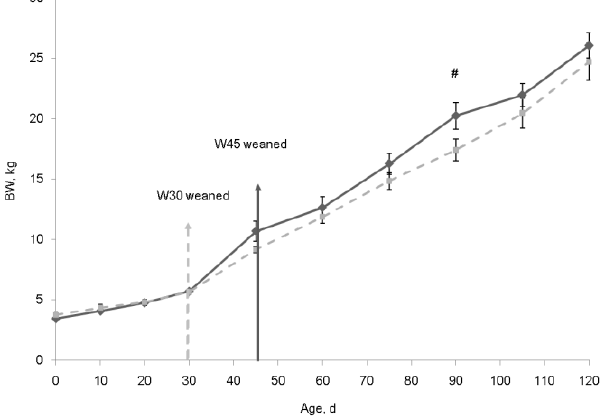
Figure 3. Cumulative BW at different ages of the growing lambs. Dashed line, lambs weaned at d 30 (W30); Solid line, lambs weaned at d 45 (W45). Error bars indicate SE. # 0.05 < p < 0.10.